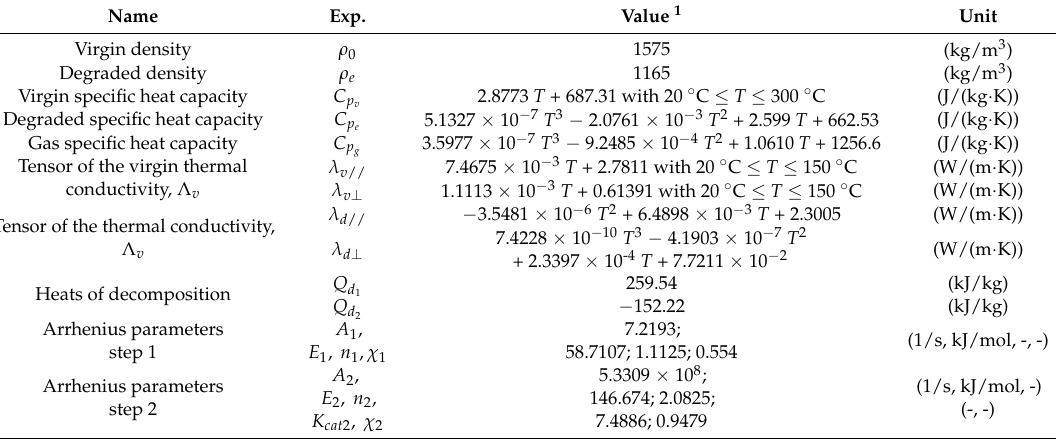
Table 5. Input data based on experimental tests on the T700/M21 composite